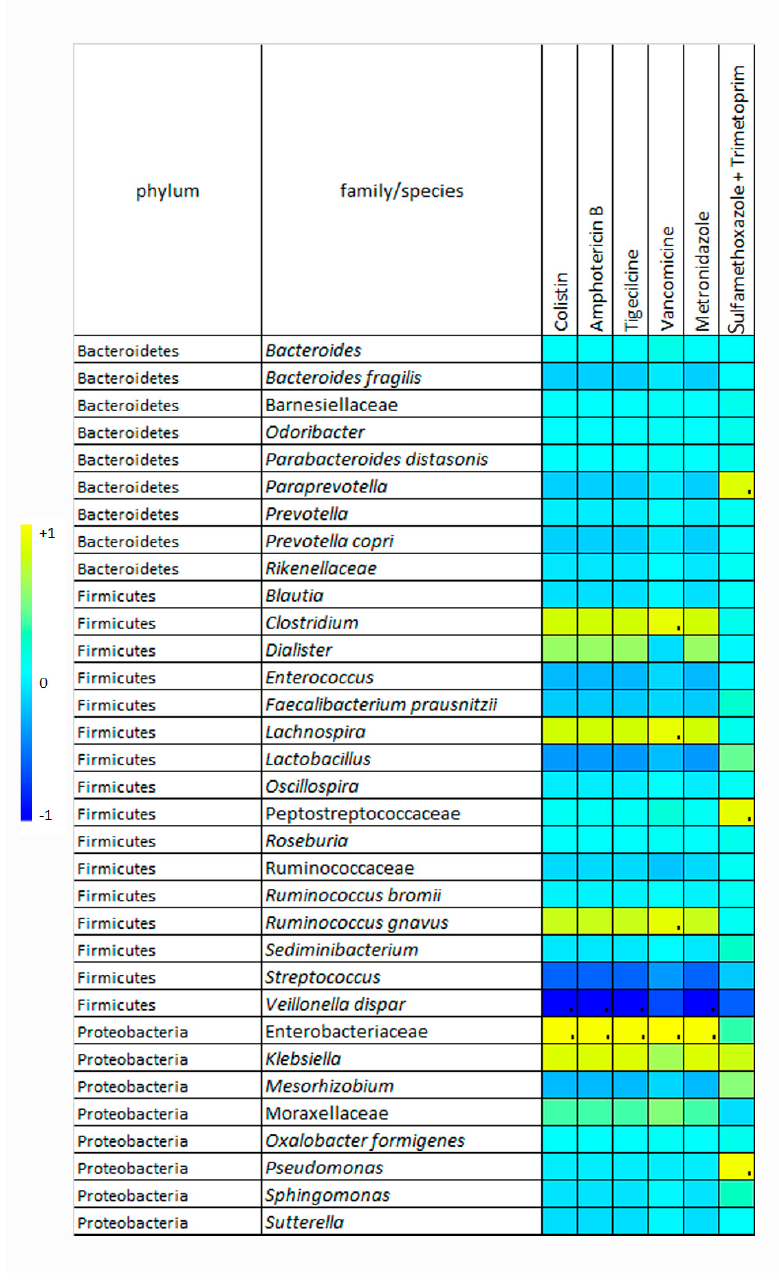
Figure 3. Heat-map depicting correlations between operational taxonomic unit (OTU) abundance and antibiotic administration. The map displays the Spearman correlation coefficients (represented by colored squares) for each OTU. The color of each square indicates the direction of the correlation (i.e., yellow positive and blue negative correlation) and the color intensity of each square indicates the correlation value; greater intensity indicates stronger